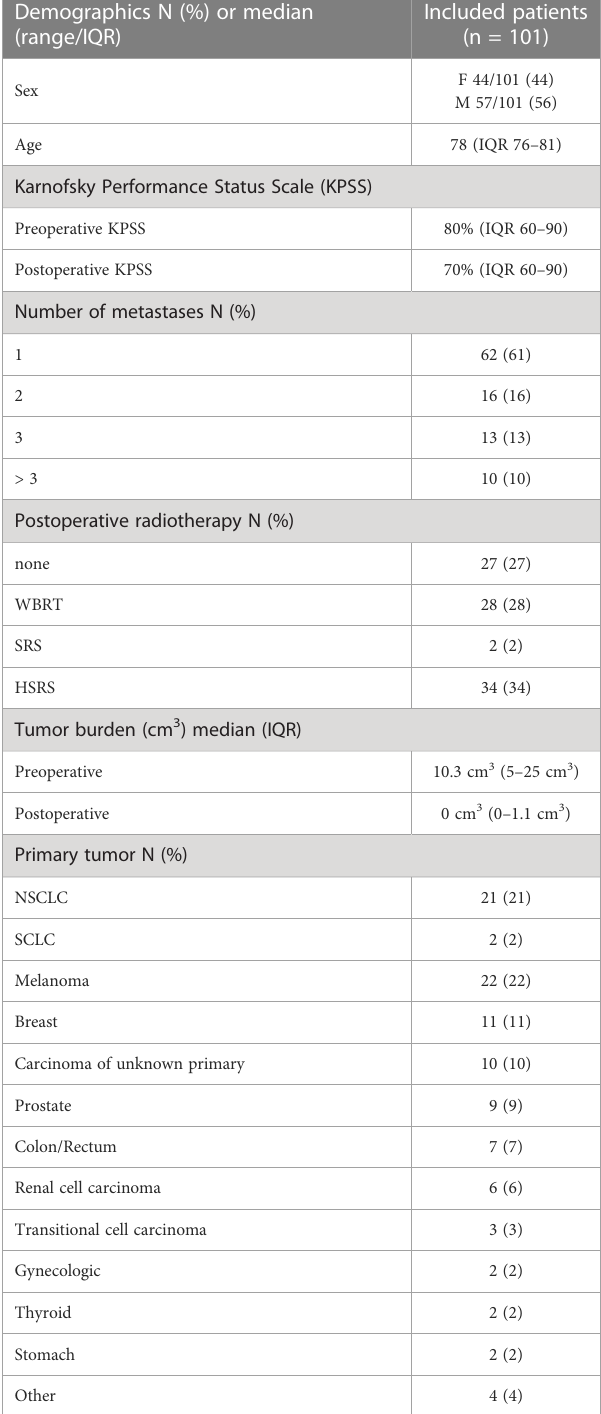
TABLE 1 Baseline characteristics of included patients, tumor data, and postoperative therapy.